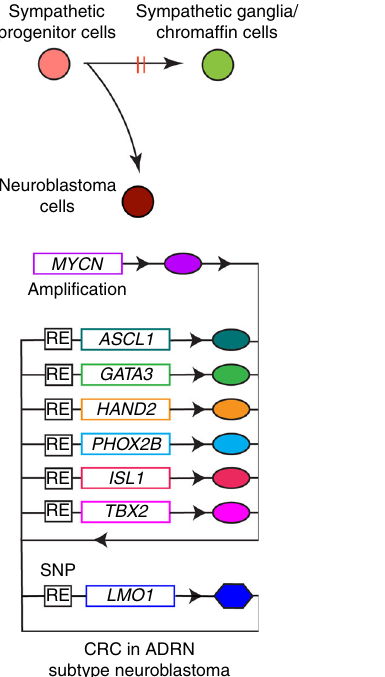
Fig. 8 Schematic image for CRC members in ADRN type of neuroblastoma. RE regulatory